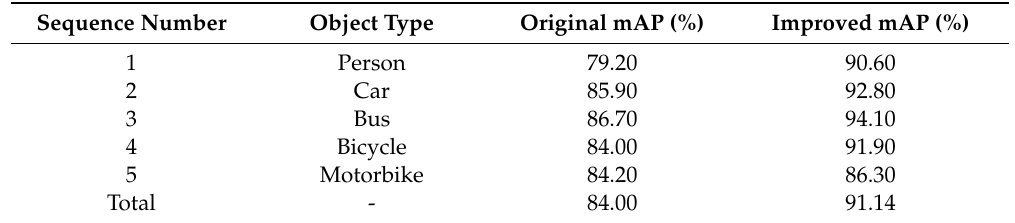
Table 6. The object detection test results of various types of objects in the actual road scenarios.